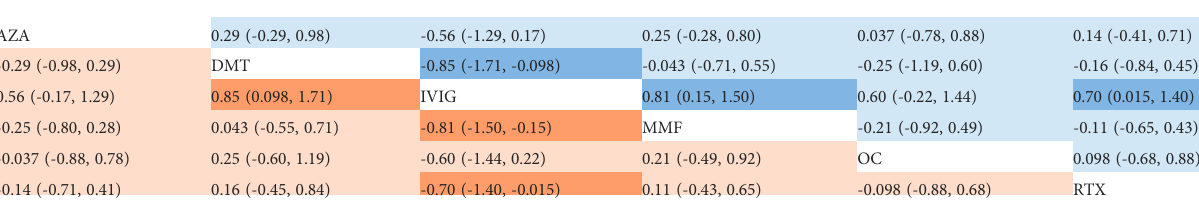
TABLE 3 Estimated differences in the ef fi cacy of treatments in reducing the annualized relapse rate in